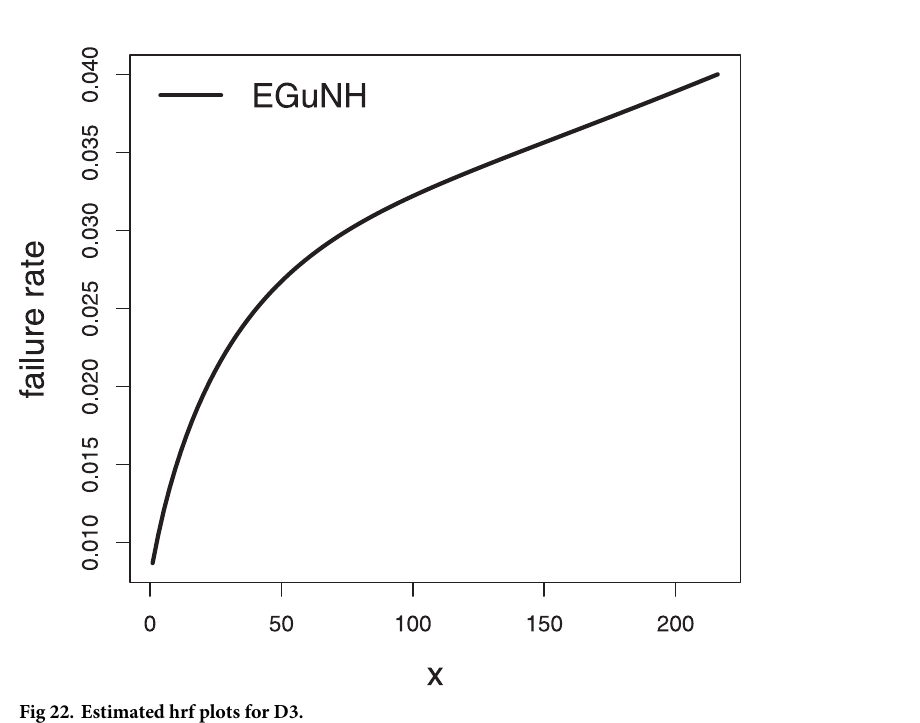
Fig 22. Estimated hrf plots for D3.